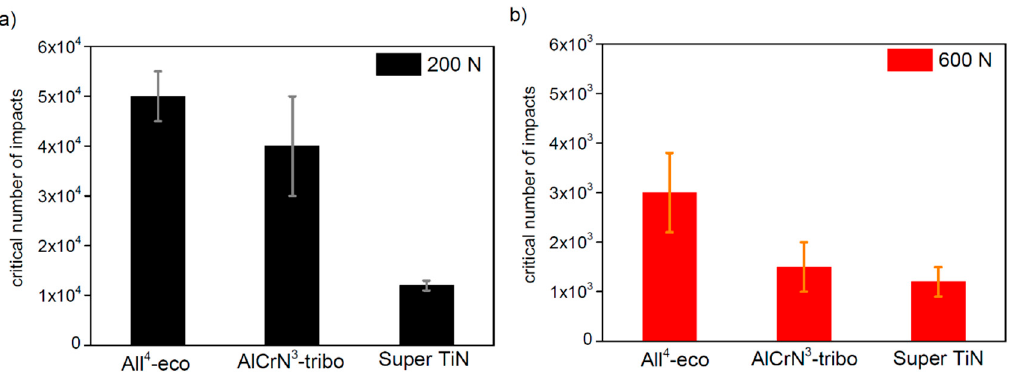
Figure 9. Comparison of the critical number of impacts (N C ) of the PVD coatings tested by the laboratory dynamic impact test under the impact load of ( a ) 200 N and ( b ) 600 N.